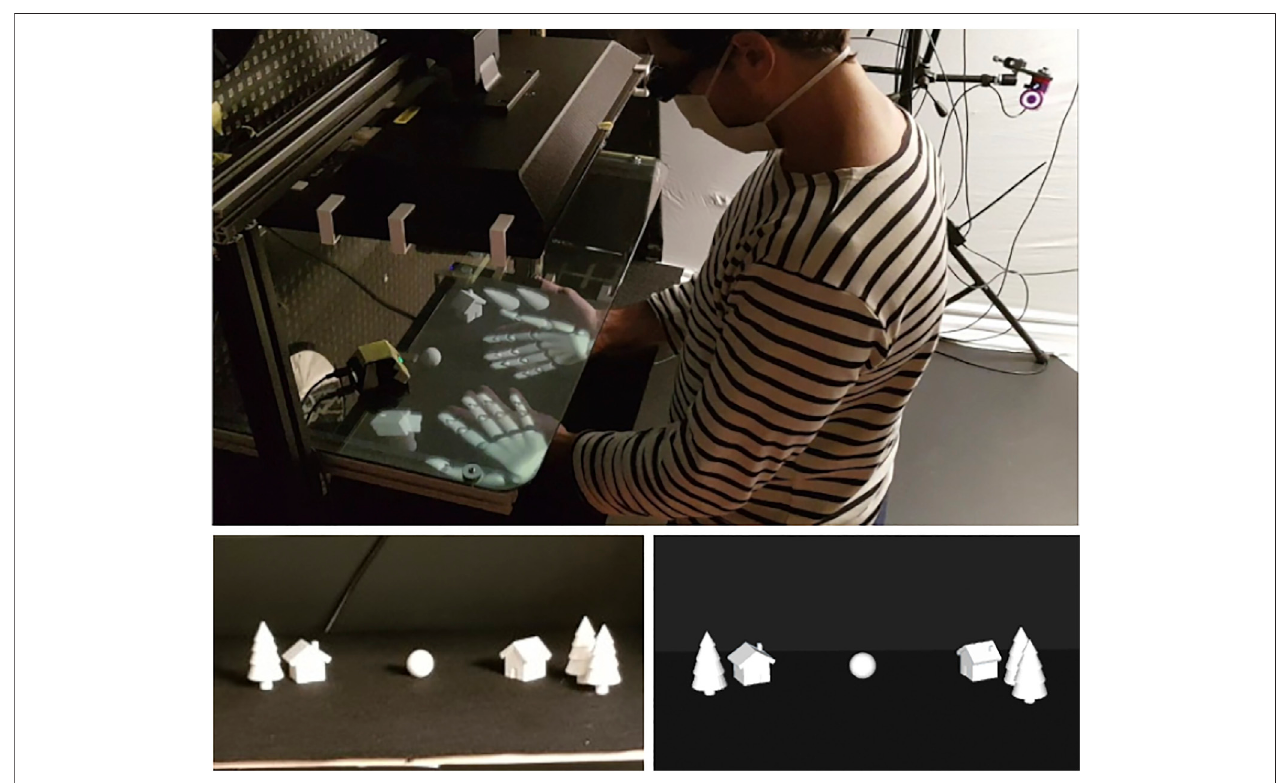
FIGURE 4 | (Top) A participant performing the task of turning his hands over during the MIXED condition (Bottom) Illustration of the object con fi guration that was seen by the user (Left) Real 3D-printed version (Right) and their virtual counterparts.